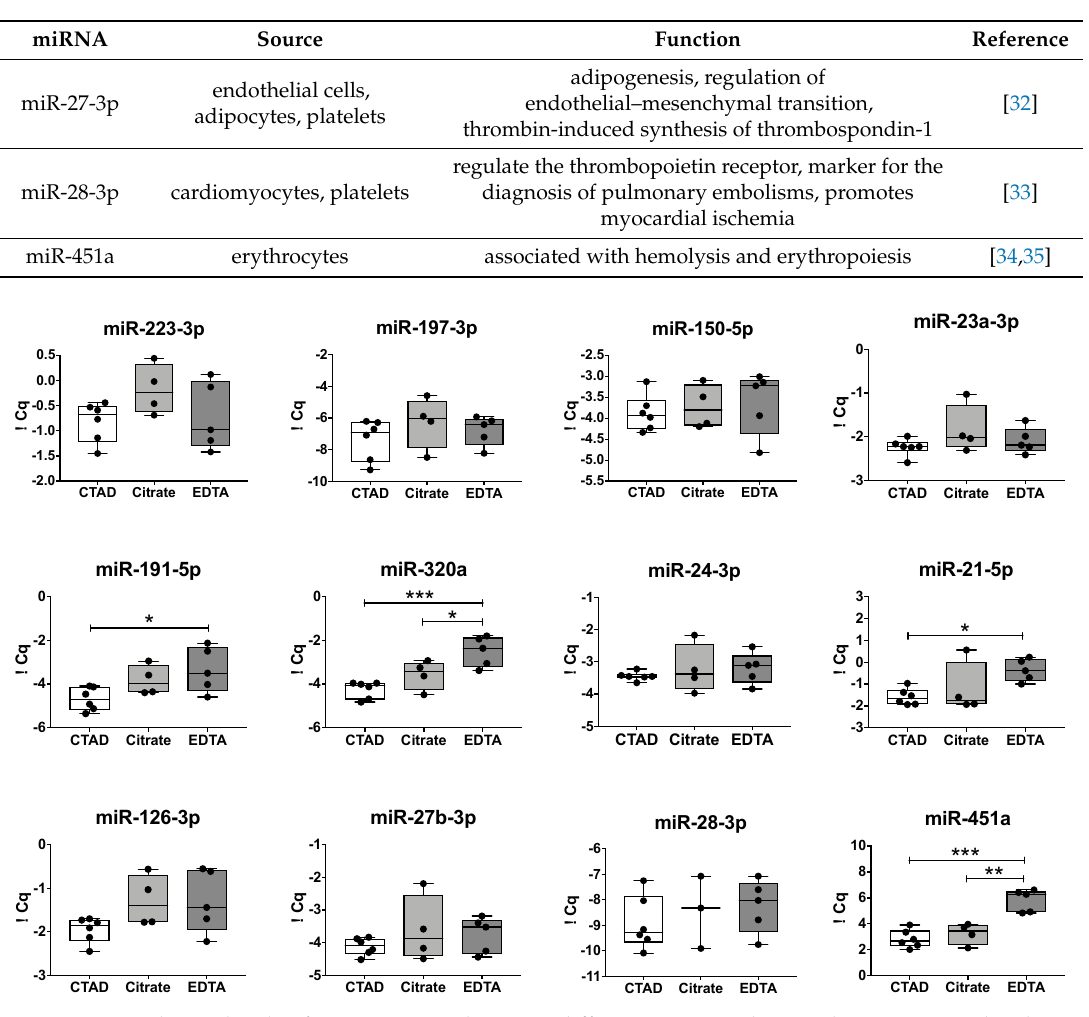
Figure 1. Plasma levels of miRNAs vary between different anticoagulants. Plasma miRNA levels were determined in 6 healthy individuals and are expressed as spike-in normalized quantitative cycles ( ∆ Cq). Plasma was prepared from citrate–theophylline–adenosine–dipyridamole (CTAD) (white), citrate (grey), or ethylenediaminetetraacetic acid (EDTA) (dark grey) blood at 4 °C within 30 min of drawing blood. Significant differences were analyzed using one-way ANOVA with Tukey correction and are depicted as * p < 0.05, ** p < 0.01, and *** p < 0.001.